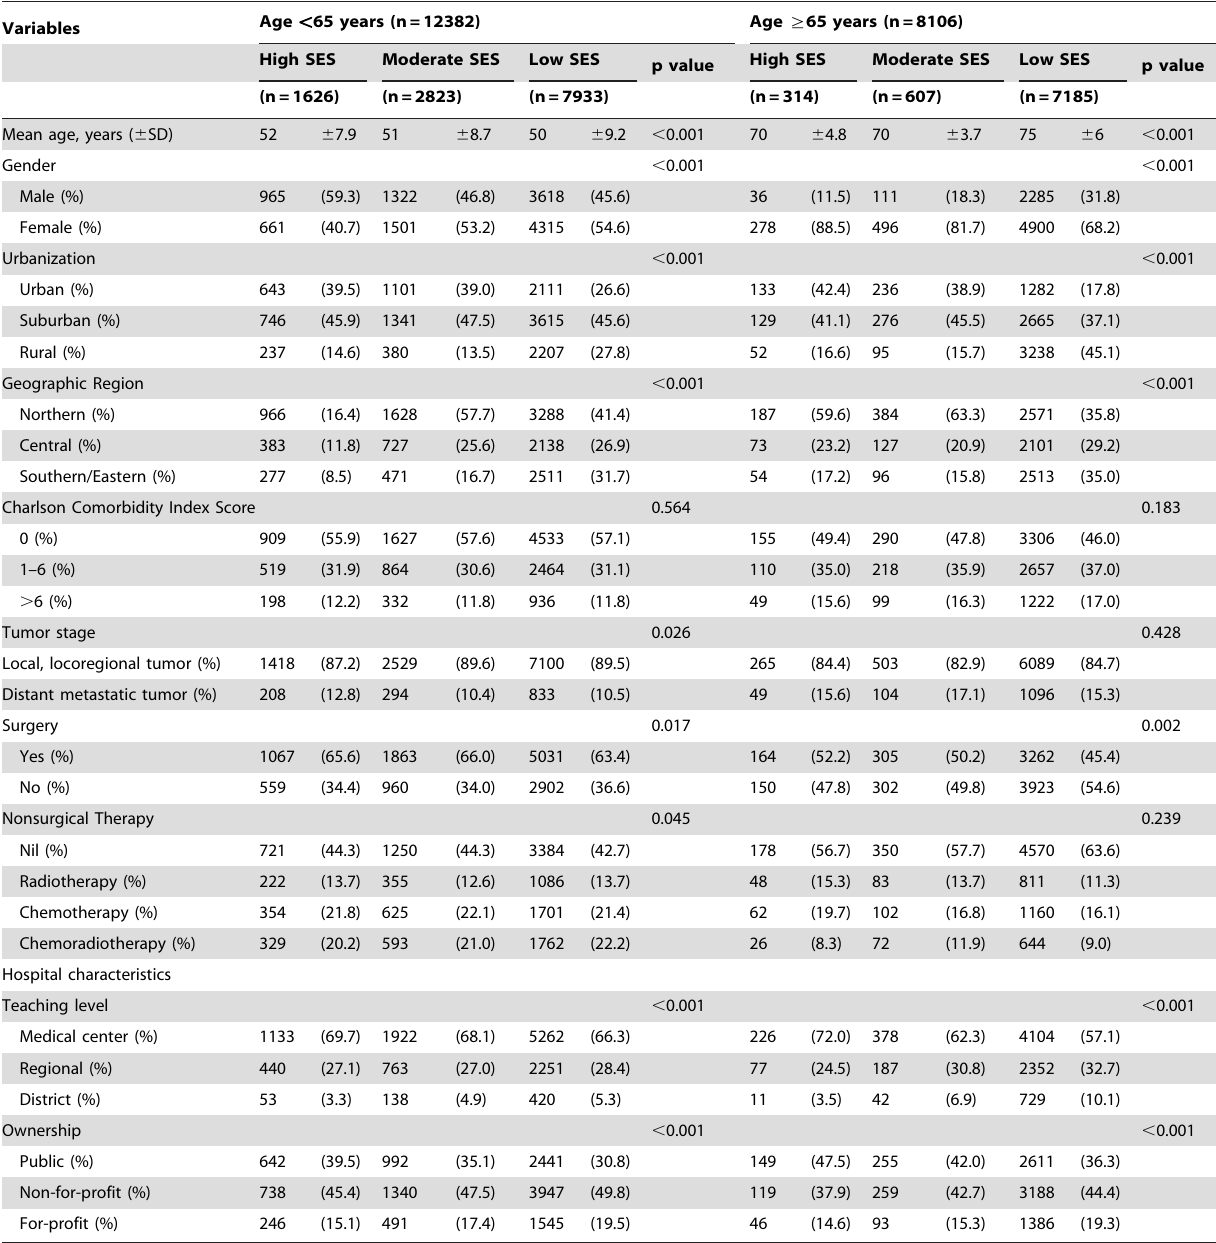
Table 1. Baseline characteristics (n